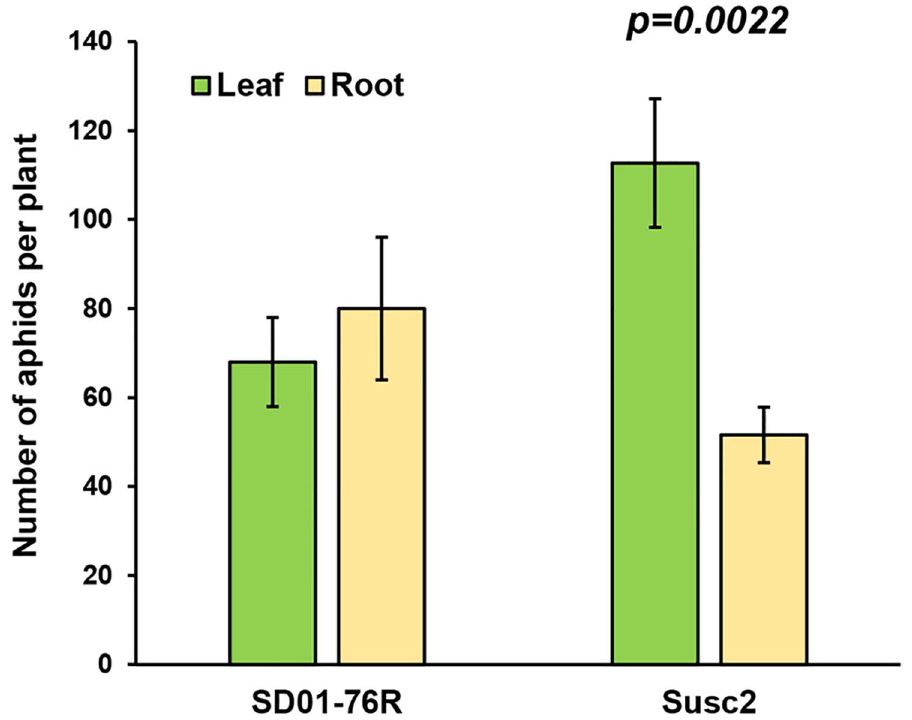
Fig 2. Aphid performanceon hairy roots and full soybean plants. Ten aphidswere introduced to each plate with one cotyledonand hairy root system, or to the V3 leaf of a soybeanplant. After one week, aphid numbers were recorded. Two different aphid-susceptible soybeancultivars were tested, SD01-76Rand Susc2. Two independentexperiments with 10 replicates for each cultivar and treatment were carried out. Comparison of aphid performance on roots and leaves of each cultivar was performed using Student’s t -test. Error bars = standarderror.